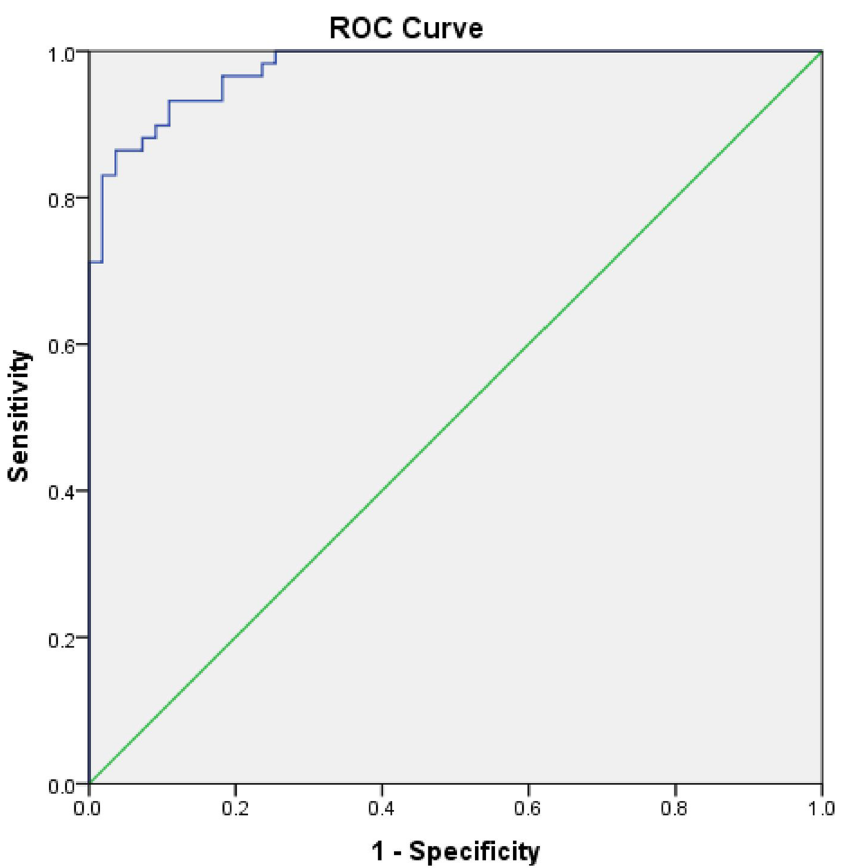
Figure 5. Receiver operating characteristic curve of p